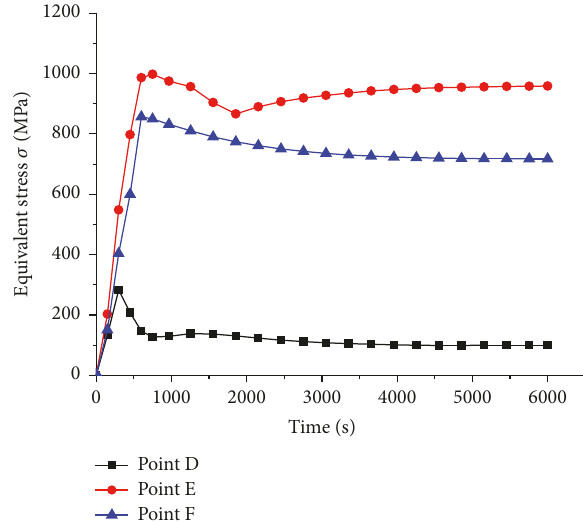
Figure 22: The equivalent stress variation of the turbine monitoring locations during start-up period.